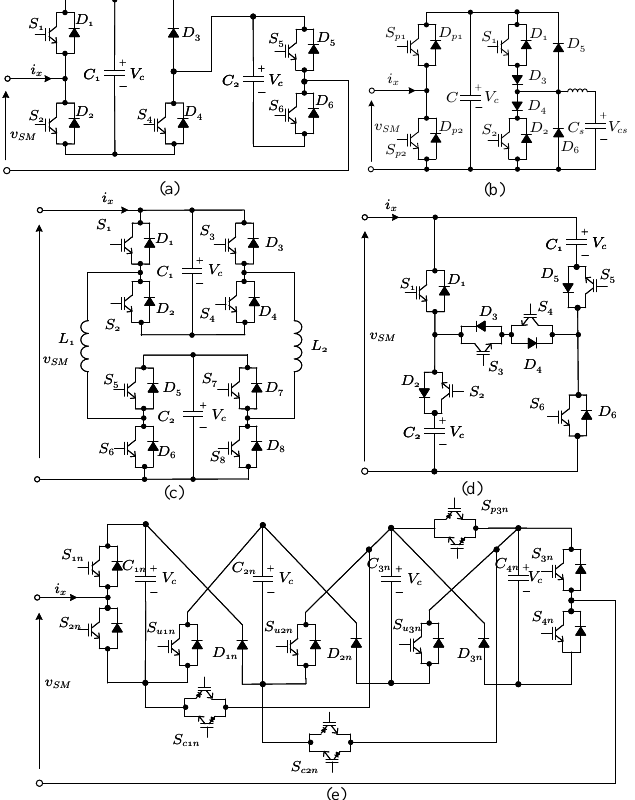
Figure 11. Others: ( a ) IHSM—Improved hybrid SM; ( b ) VIC-SM—Virtual infinite capacitor SM; ( c ) TL-CFBSM—Three-level clamp full-bridge SM; ( d ) MSCSM—Modified switched capacitor SM; and ( e ) LSM—Lattice SM.